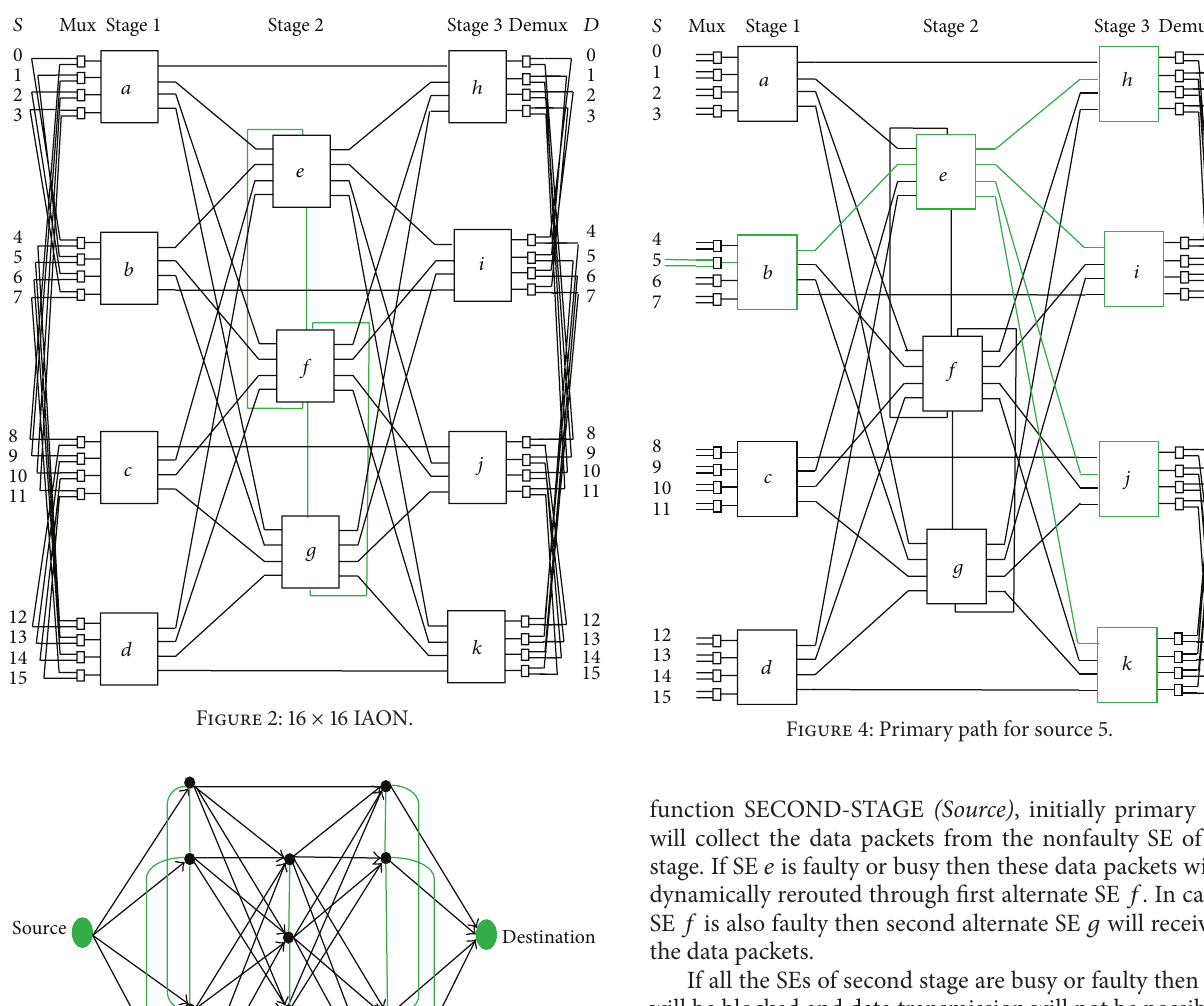
Figure 4: Primary path for source